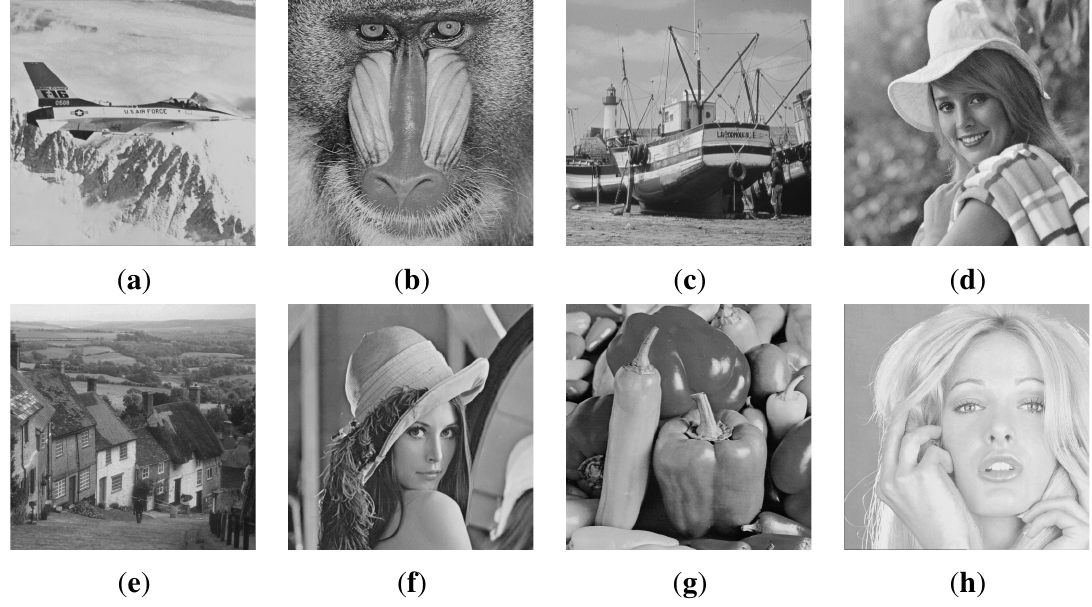
Figure 6. Stego images (MGEMD n = 3 , k = 3 ). ( a ) F16; ( b ) baboon; ( c ) boat; ( d ) Elaine; ( e ) Gold Hill; ( f ) Lena; ( g ) pepper; ( h ) Tiffany. Table 3. Comparison table for the PSNR and non-modified